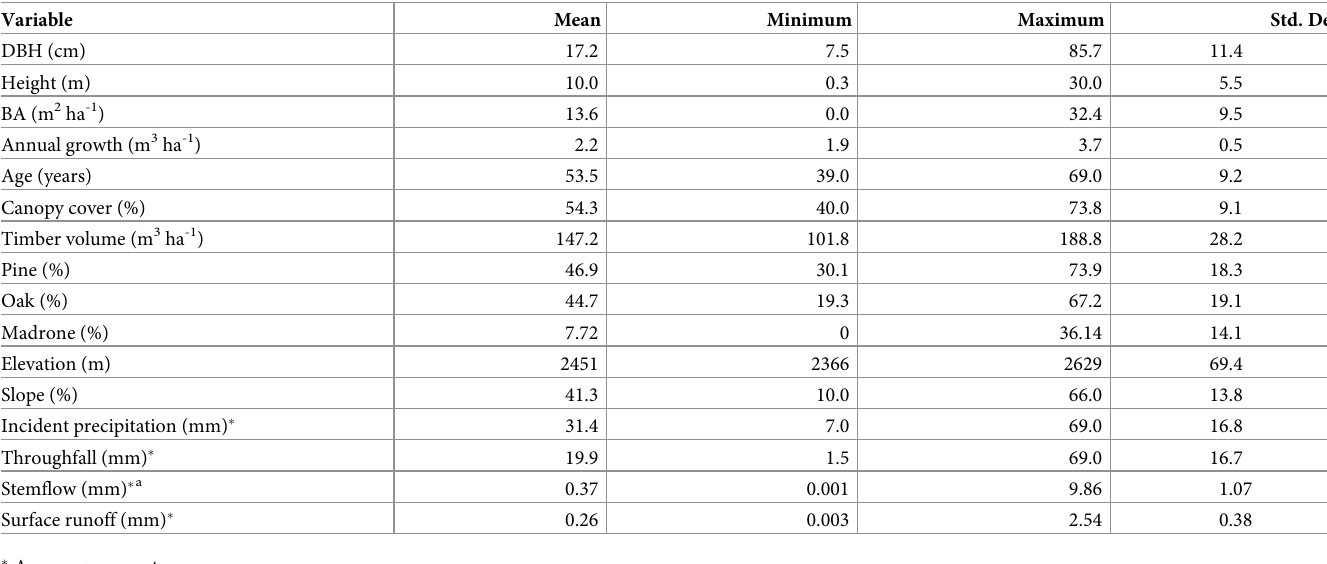
Table 1. Site and stand structural characteristics of the experimental